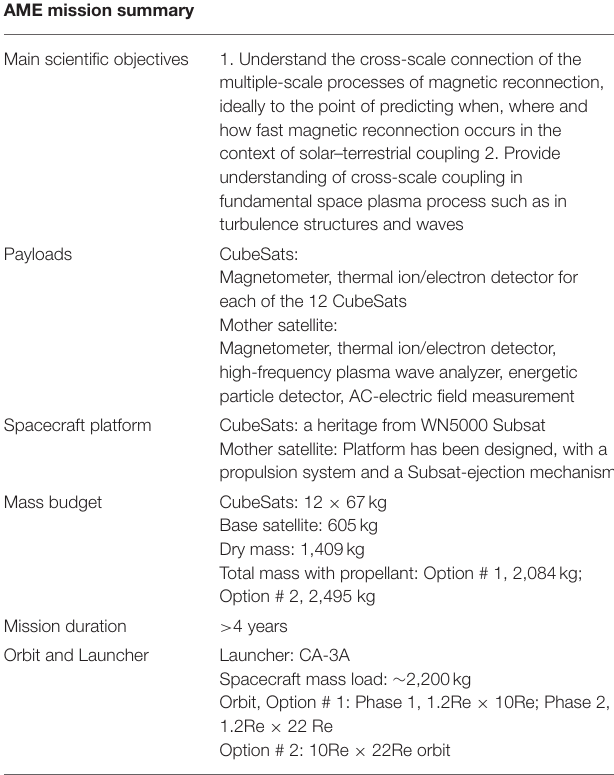
TABLE 1 | AME mission profile